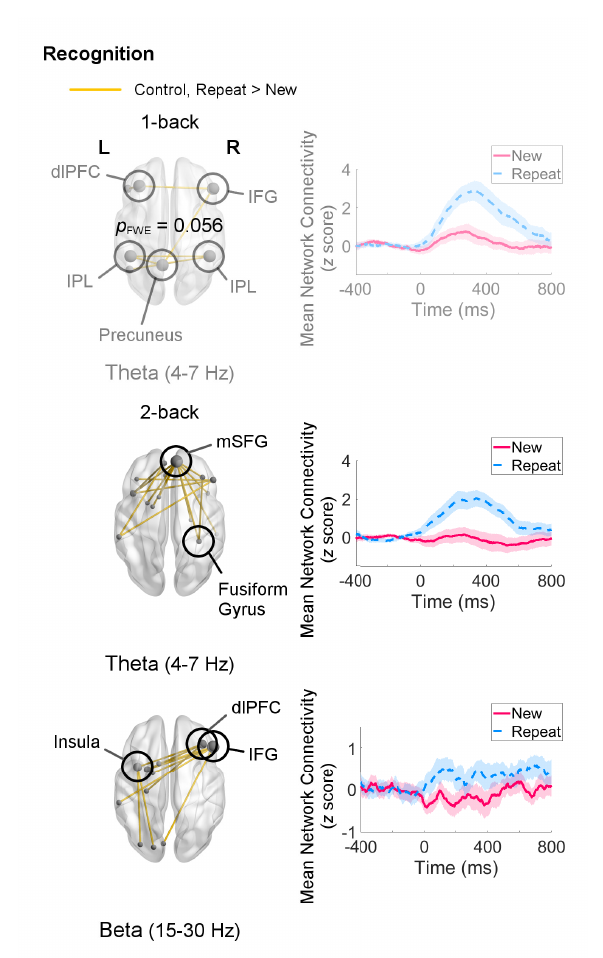
FIGURE 5 | Networks showing increased connectivity during recognition of repeated visual stimuli (Repeat versus New trials, 0 – 400 ms, poststimulus onset) for the 1-back and 2-back loads in the control group (left) and mean connectivity of these networks between − 400 – 800 ms (right). Node size is scaled by number of connections. Connectivity values are given as z scores. In the 1-back load, control adults recruited a theta-band network, but it was only signi fi cant at a trend level ( p FWE = 0.056). In the 2-back load, they exhibited greater connectivity in networks in the theta ( p FWE = 0.0084) and beta ( p FWE = 0.015) bands. Adults with autism spectrum disorder (ASD) did not show differential connectivity during